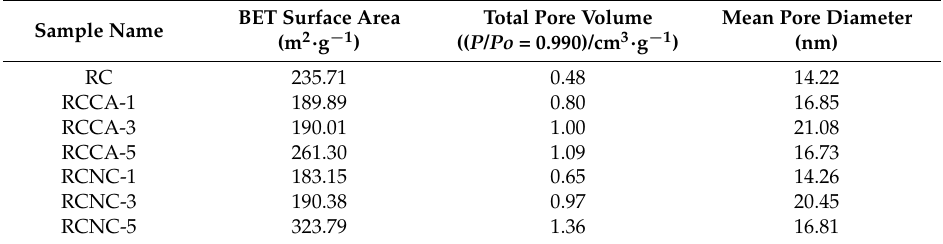
Table 2. Specific surface, total pore volume, and mean pore diameter of manufactured